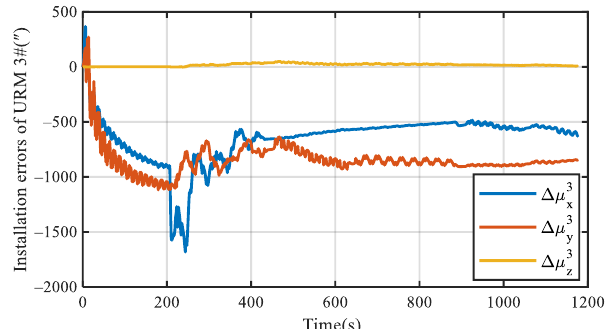
Figure 12. Experimental results of installation errors for URM 3#.